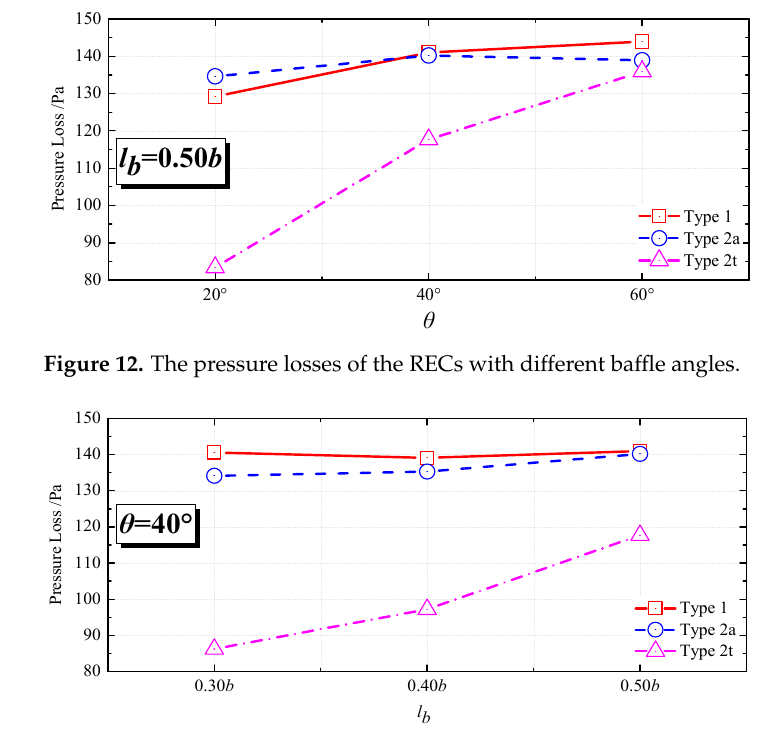
Figure 13. The pressure losses of the RECs with different baffle lengths.